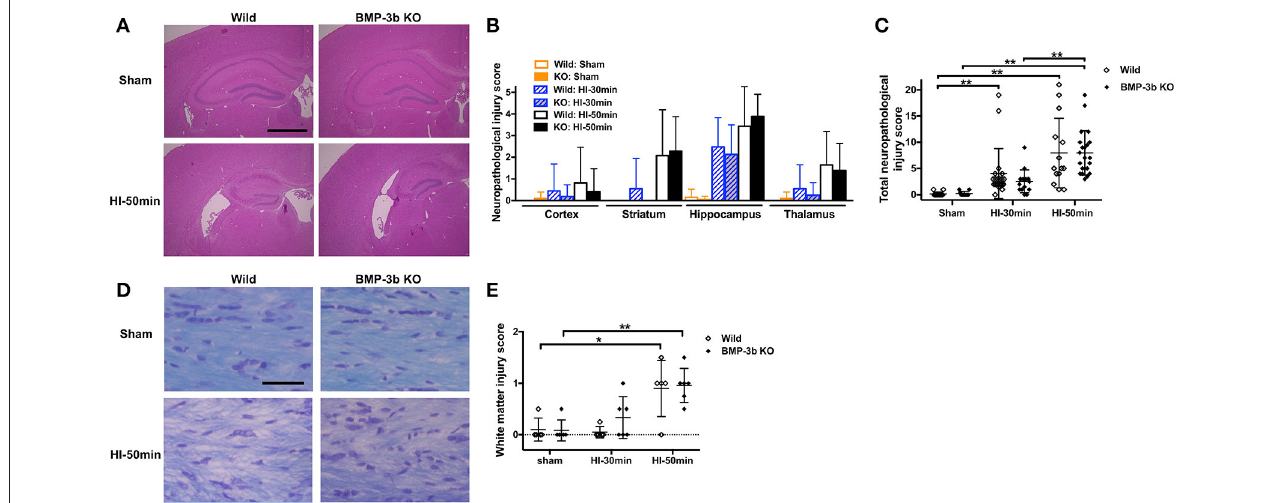
FIGURE 7 | (A) Representative images of brain coronal sections stained with hematoxylin and eosin at 14 days after the surgery. Scale bar, 1mm. (B) Semi-quantitative neuropathological injury scores were evaluated in hematoxylin-eosin-stained sections. The scores in each region are shown. Mean ± SD. Significant differences between groups treated with different degrees of insult are not shown with symbols in this figure. (C) The total scores of the four regions examined. The maximum (i.e., worst) score was 22. Wild Sham, n = 12; Wild HI-30min, n = 20; Wild HI-50min, n = 14; BMP-3b KO Sham, n = 12; BMP-3b KO HI-30min, n = 16; and BMP-3b KO HI-50min, n = 22. (D) Representative images of the Klüver–Barrera staining of the medial part of the corpus callosum. Scale bar, 50 µ m. (E) Semi-quantitative white matter injury scores were evaluated in Klüver-Barrera-stained sections. The maximum (i.e., worst) score was 3. Each group, n = 5. * p < 0.05, ** p < 0.01.